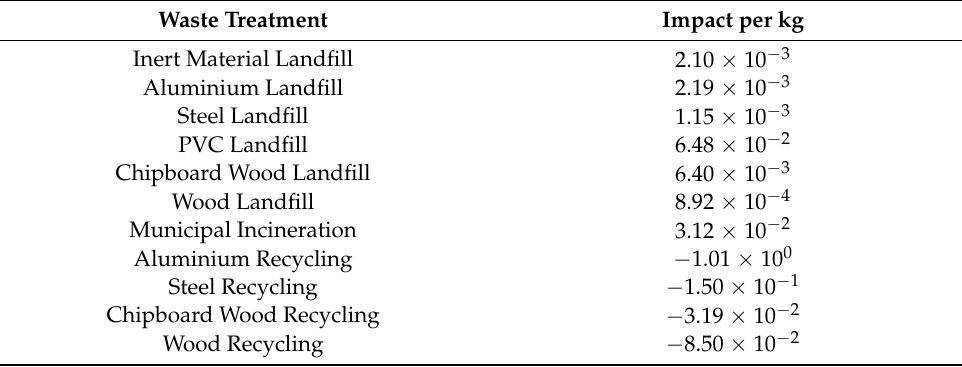
Table 7. Environmental impact of waste treatments for the case